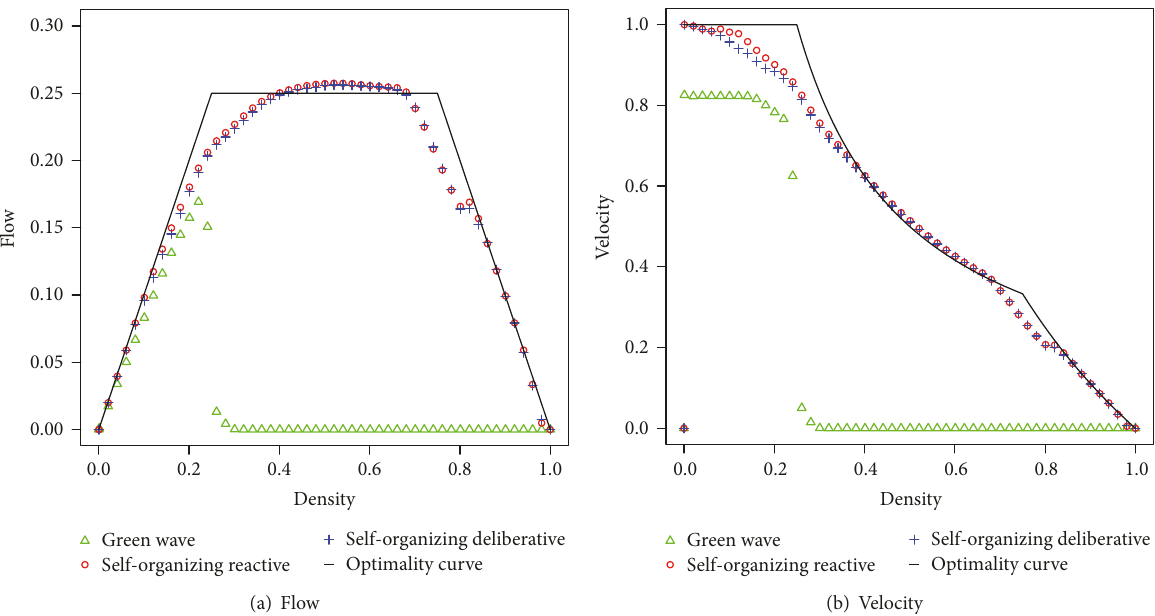
Figure 8: The reactive and deliberative self-organizing methods achieve good performance for all densities compared to the green wave method. Both self-organizing methods are close to the optimality curves (see